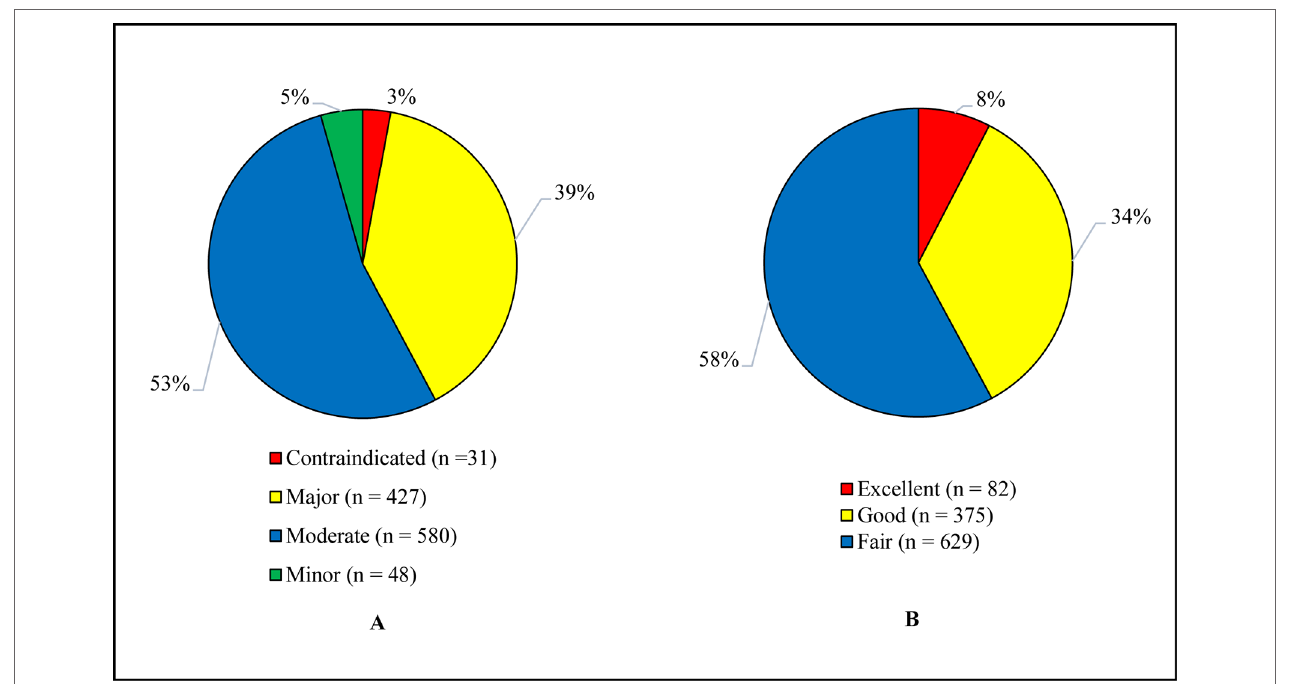
FIGURE 2 | (A) Severity levels of pDDIs. (B) Documentation levels of pDDIs. The total identified pDDIs were categorized based on the severity and documentation levels. pDDIs, potential drug-drug